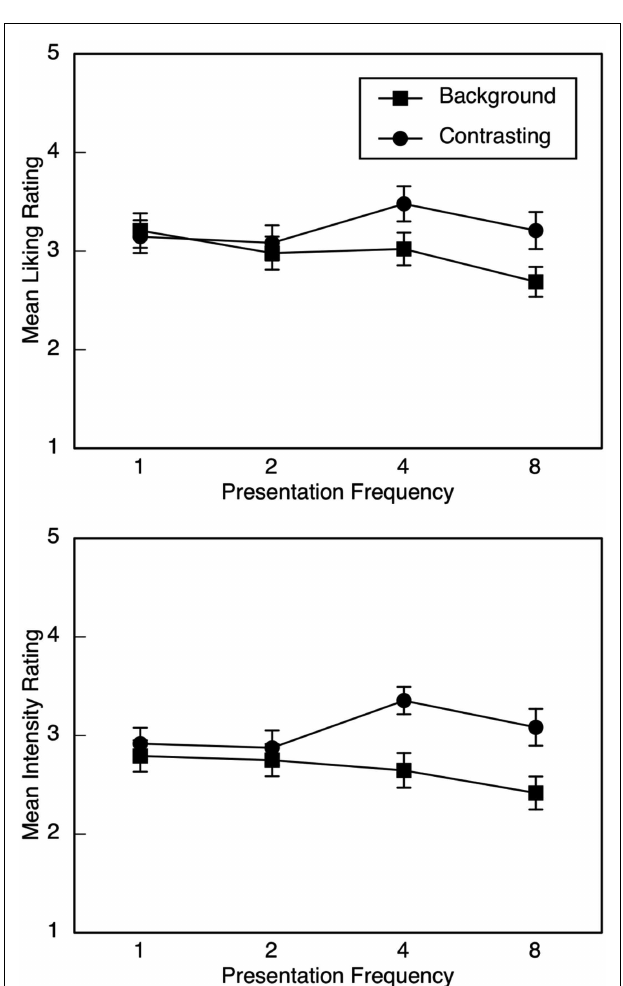
FIGURE 2 | Mean liking (upper panel) and emotion-intensity (lower panel) ratings in Experiment 2, illustrated as a function of emotion type (background or contrasting) and presentation frequency of the background emotion (1, 2, 4, or 8). Error bars are SE.